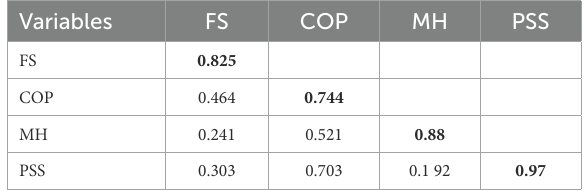
TABLE 3 Correlation and discriminant validity.